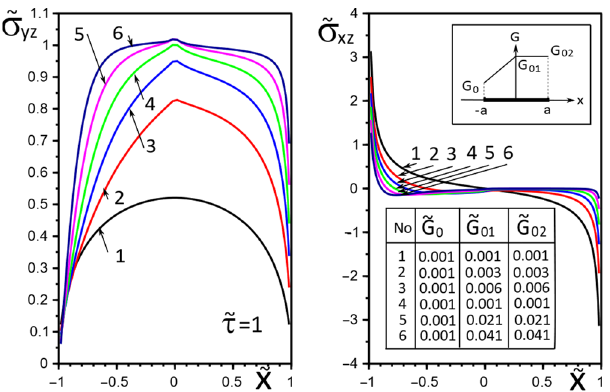
Figure 7. Stress distribution along with the upper interface (inclusion—matrix half-space S 2 ) with a piecewise linear distribution of material stiffness.